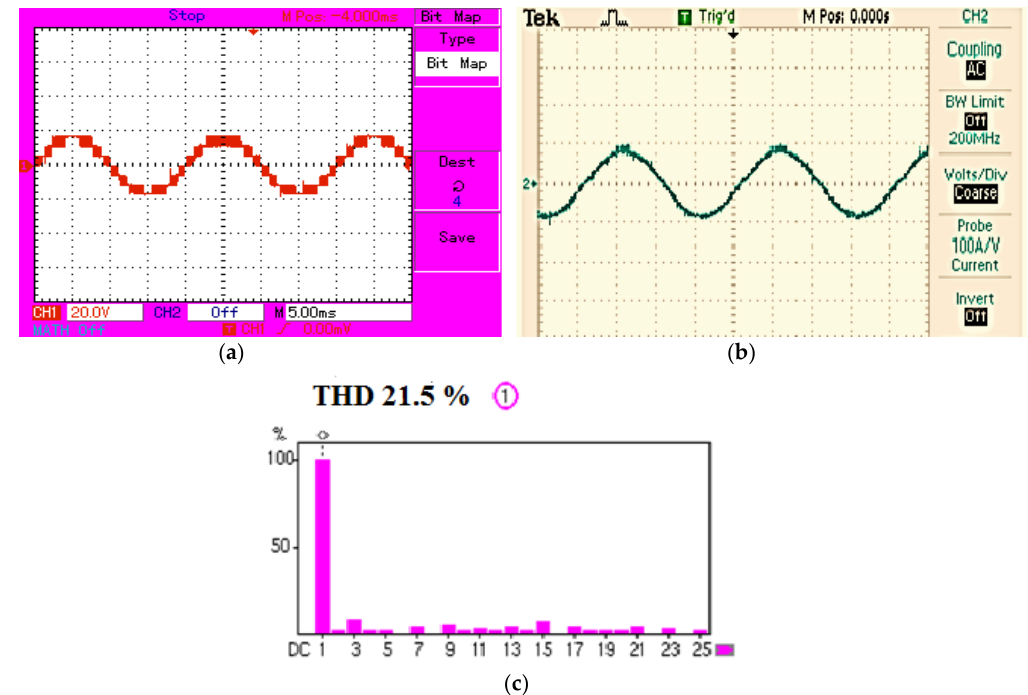
Figure 18. Experimental output waveform for the APODPWM strategy. ( a ) Voltage; ( b ) Current; ( c ) FFT plot for the output voltage.